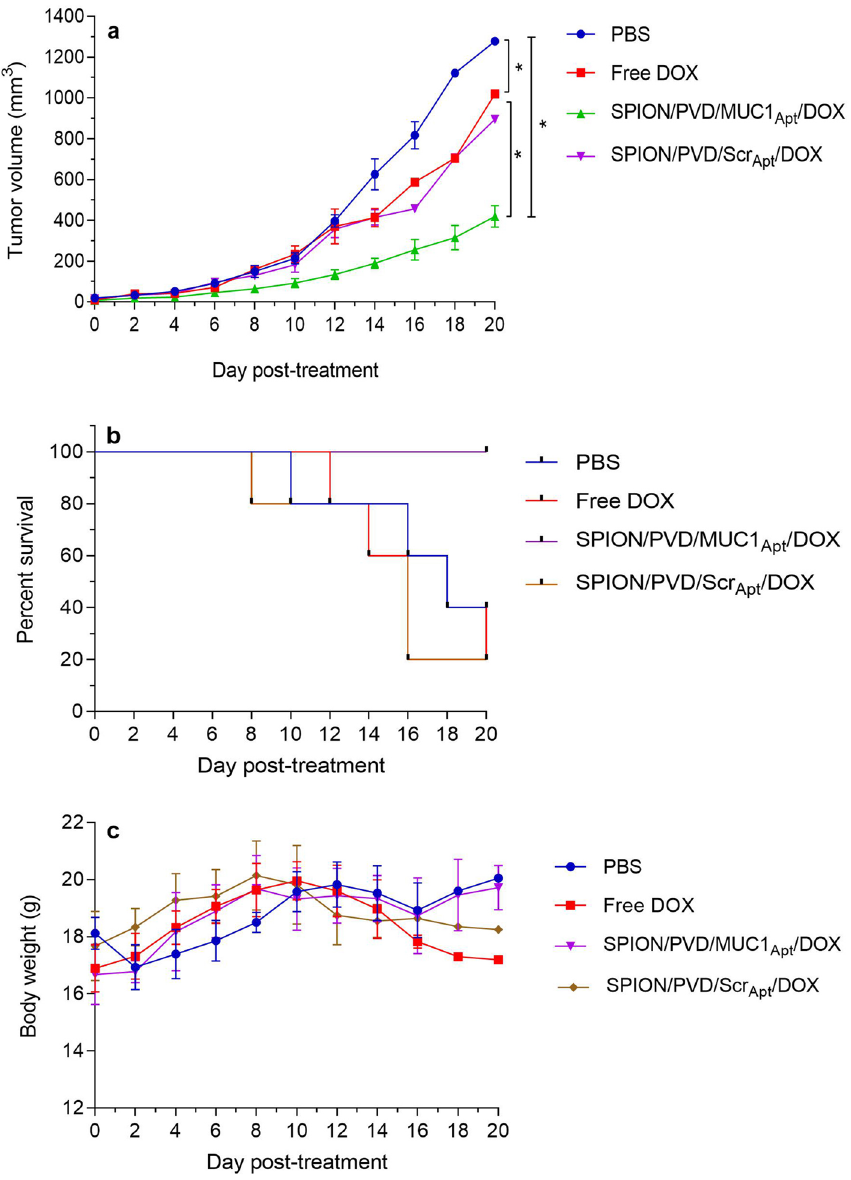
Figure 8. Tumor growth-inhibitory impact ( a ), Kaplan–Meier survival curve of the mice ( b ) and body weight of tumor-bearing mice ( c ) of SPION/PVD/MUC1 Apt /DOX compared with PBS (control), free DOX, and SPION/PVD/Scr Apt /DOX groups (n = 5, error bars represents SD). Statistical analysis was performed using GraphPad Prism Version 8.0 (https:// www. graph pad.